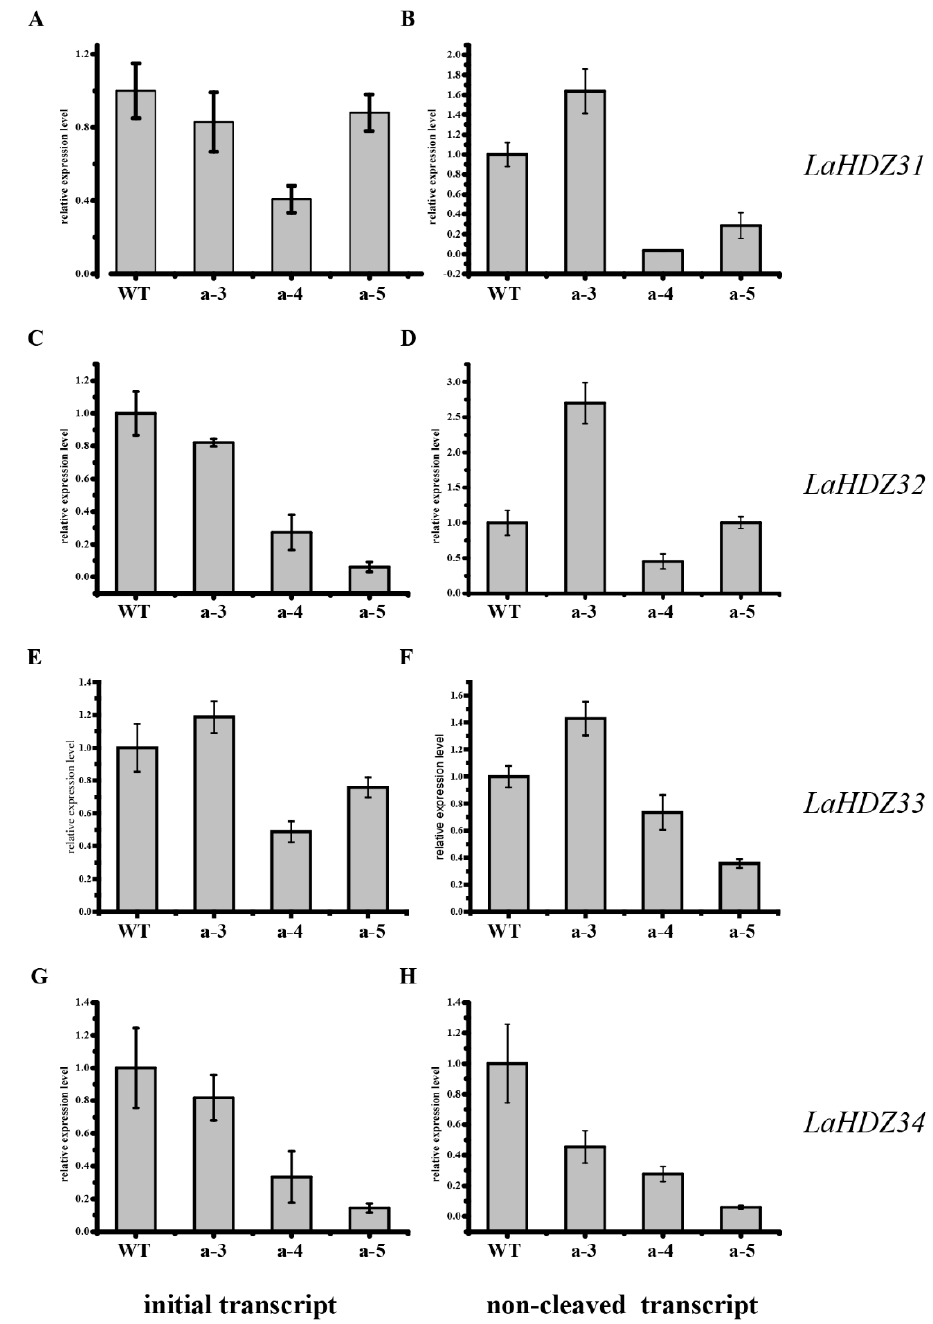
Figure 8. Analysis of the cleaved degree of LaHDZ31–34 . ( A ) Expression patterns of initial transcripts of LaHDZ31 in the wild-type (WT), a-3, a-4, and a-5 lines. ( B ) Expression patterns of the non-cleaved transcripts of LaHDZ31 in the WT, a-3, a-4, and a-5. Expression patterns of the ( C ) initial transcripts of LaHDZ32 in WT, a-3, a-4, and a-5; ( D ) non-cleaved transcripts of LaHDZ32 in WT, a-3, a-4, and a-5; ( E ) initial transcripts of LaHDZ33 in WT, a-3, a-4, and a-5; ( F ) non-cleaved transcripts of LaHDZ33 in WT, a-3, a-4, and a-5; ( G ) initial transcripts of LaHDZ34 in WT, a-3, a-4, and a-5; and ( H ) non-cleaved transcripts of LaHDZ34 in WT, a-3, a-4, and